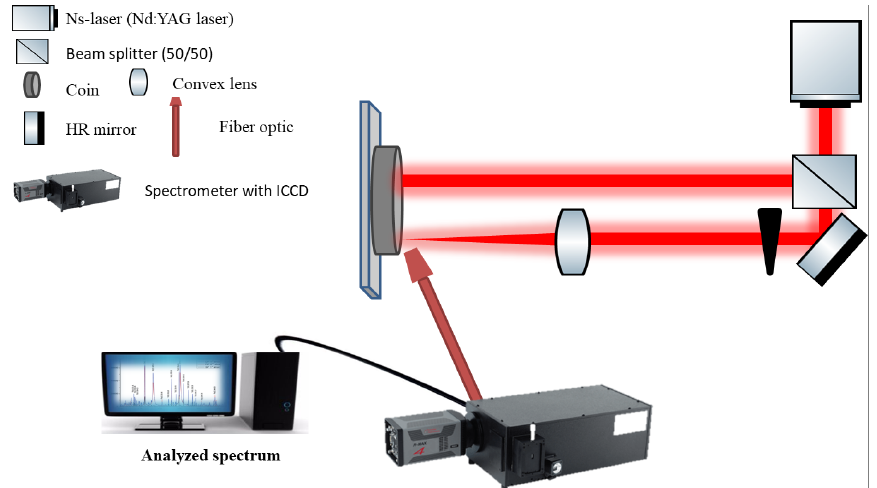
Figure 2. Experimental set-up for the use of a pulsed laser beam for laser cleaning and LIBS investigation.